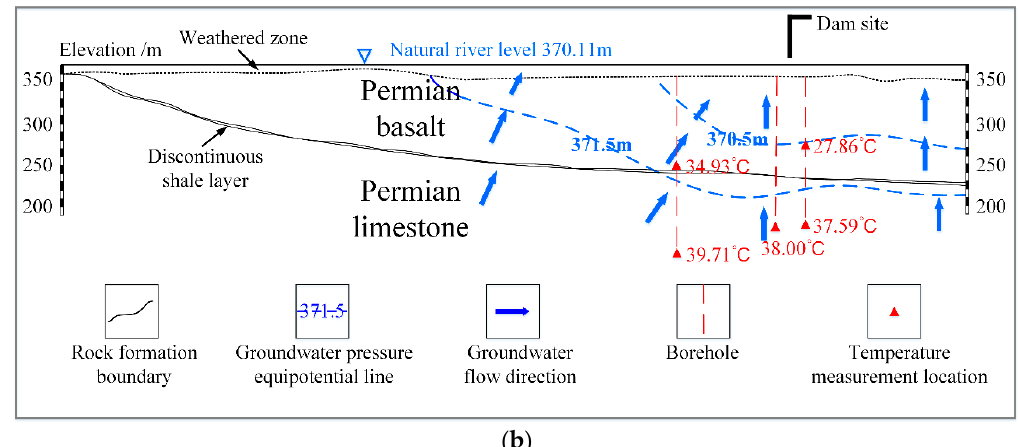
Figure 2. Profiles of the Xiluodu dam site: ( a ) transverse section/2a section in Figure 1; ( b ) river-along section/2b section in Figure 1.